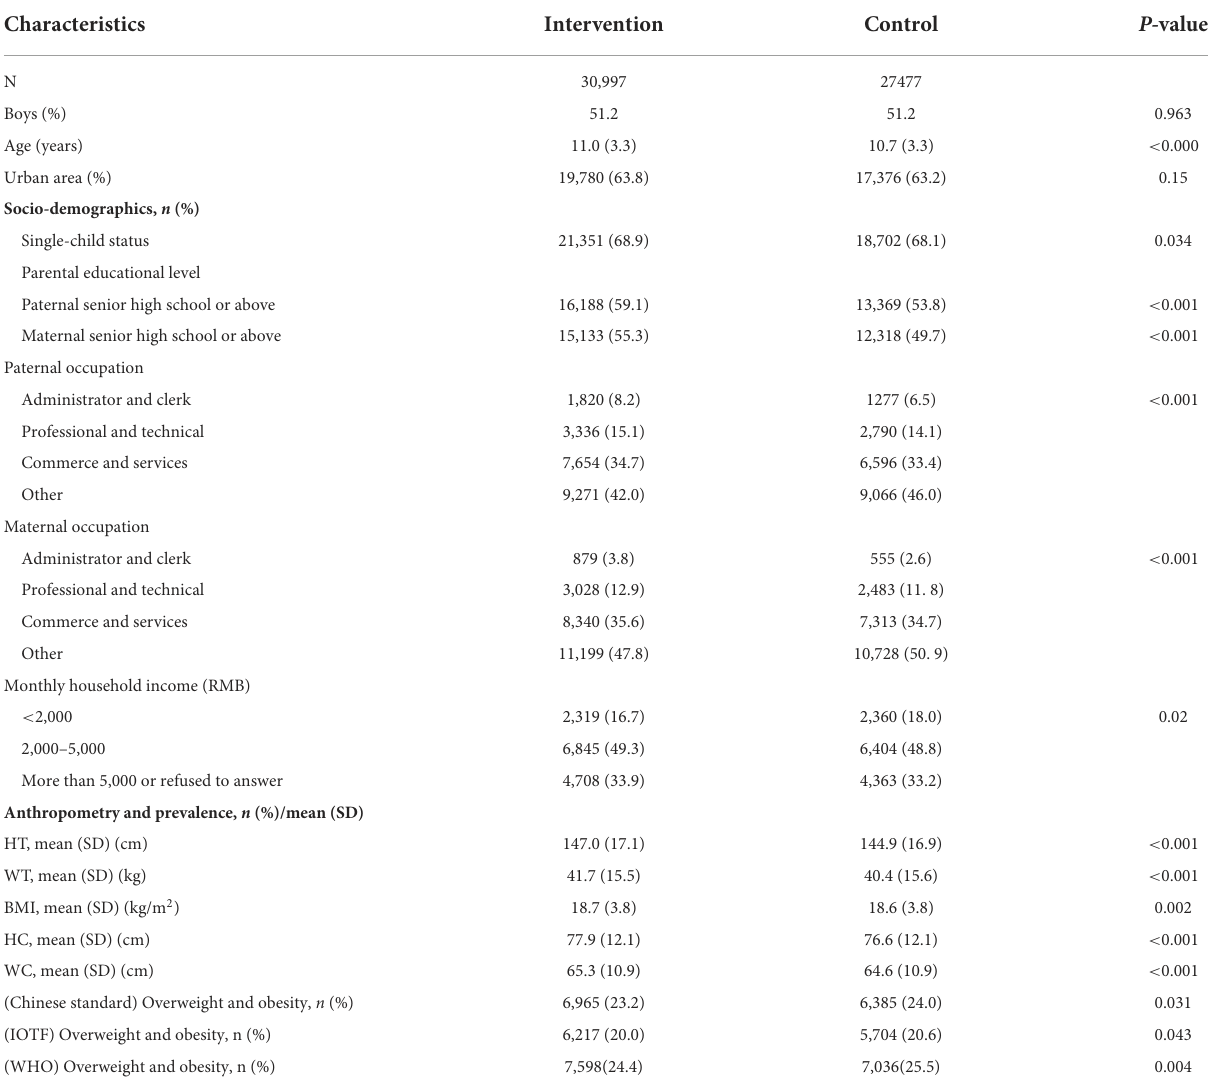
TABLE 1 Baseline characteristics of study